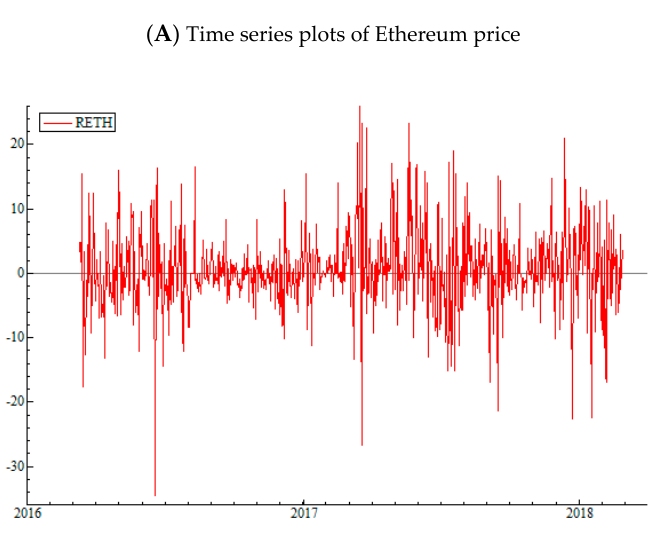
Figure 2. Time Series Plots of Ethereum Price and Return. ( A ) Presents the plot historical plot of daily closing prices for Ethereum between October 3, 2016 and February 28, 2018; ( B ) presents the daily returns for Ethereum for the same time period. The data is obtained from